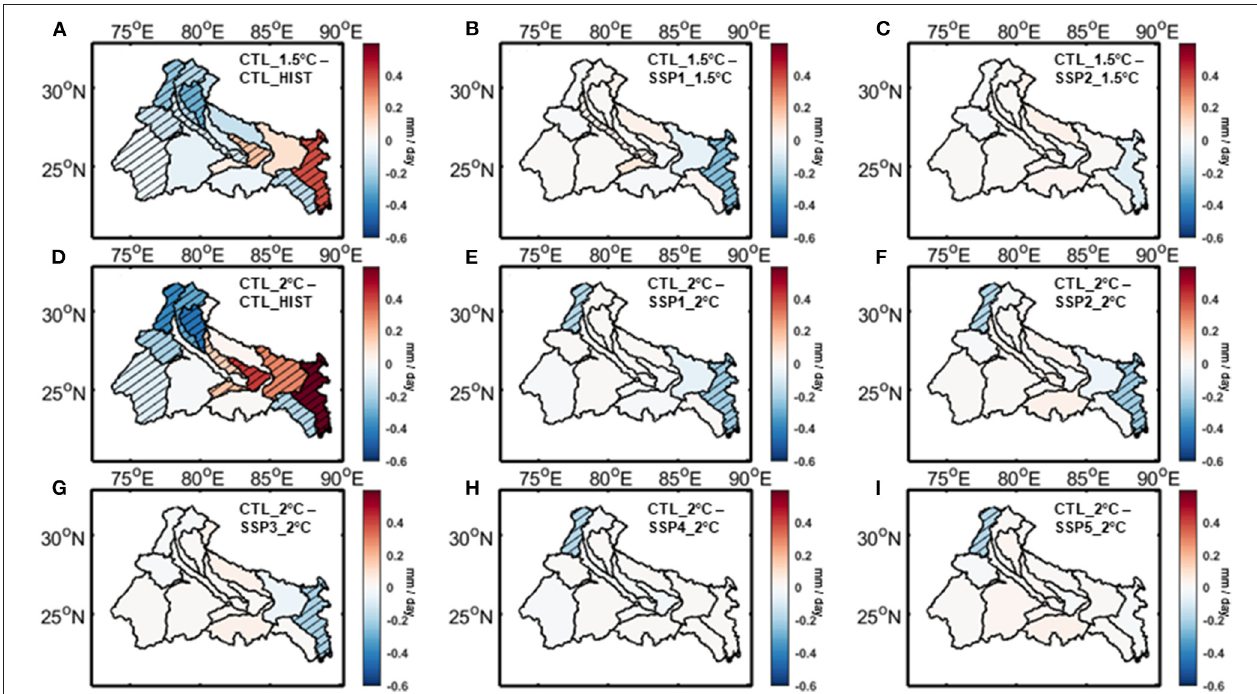
FIGURE 8 | Changes in VIC simulated total runoff associate with climate change for (A) 1.5 ◦ C warming, (D) 2 ◦ C warming and land use change for (B) SSP1_1.5 ◦ C scenario, (C) SSP2_1.5 ◦ C scenario, (E) SSP1_2 ◦ C scenario, (F) SSP2_2 ◦ C scenario, (G) SSP3_2 ◦ C scenario, (H) SSP4_2 ◦ C scenario, (I) SSP5_2 ◦ C scenario over Ganga river basin. Hatched regions denote areas with statistically significant